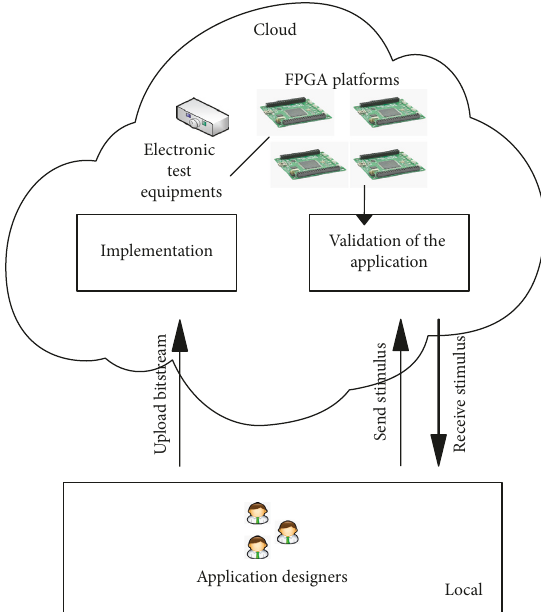
Figure 4: An FPGA Platform as a Service model. Table 4: Summary of the FPGA platform as a